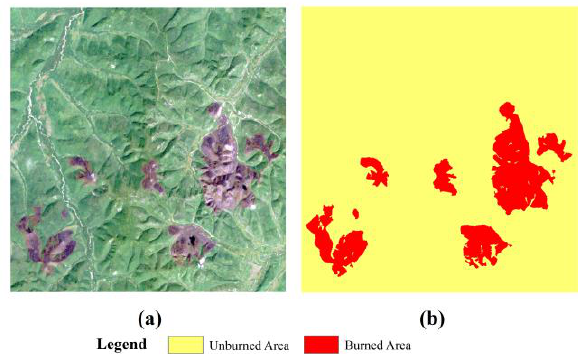
Figure 4. Landsat image after fire and its ground truth map: (a) post-fire image; (b) ground truth